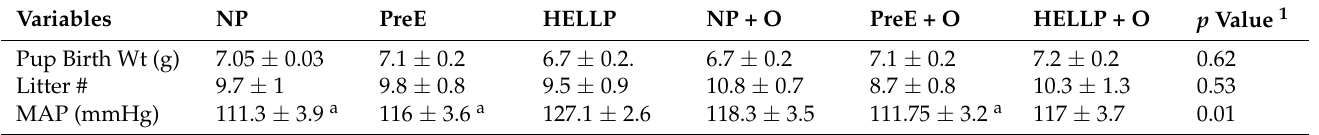
Table 1. Birth outcomes and mean arterial pressure for dams in the current study. Birth outcomes were collected on post-partum day 0, which was marked by the delivery of rat pups. Mean arterial pressure was collected at the end of the study at post-partum week